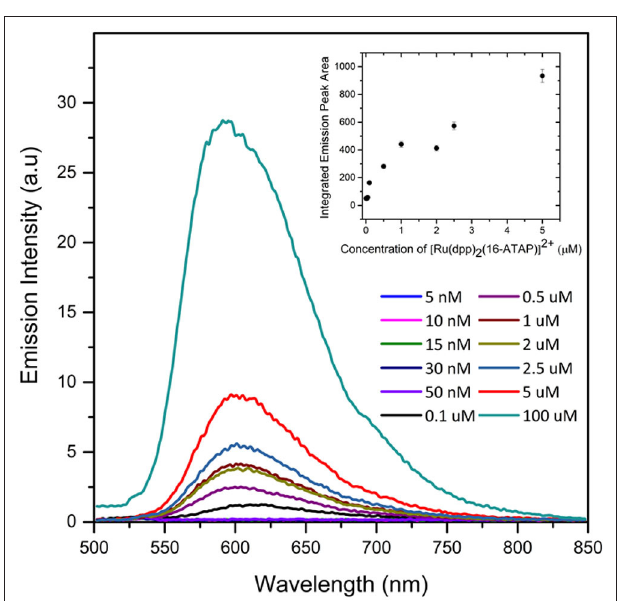
FIGURE 3 | Concentration dependence of emission spectroscopy of [Ru(dpp) 2 (16-ATAP)] 2 + in aqueous PBS buffer (1% v/v ACN) and plot of integrated area of [Ru(dpp) 2 (16-ATAP)] 2 + as a function of concentration (inset) ( λ exc 454nm; excitation and emission slit width 5nm; n =